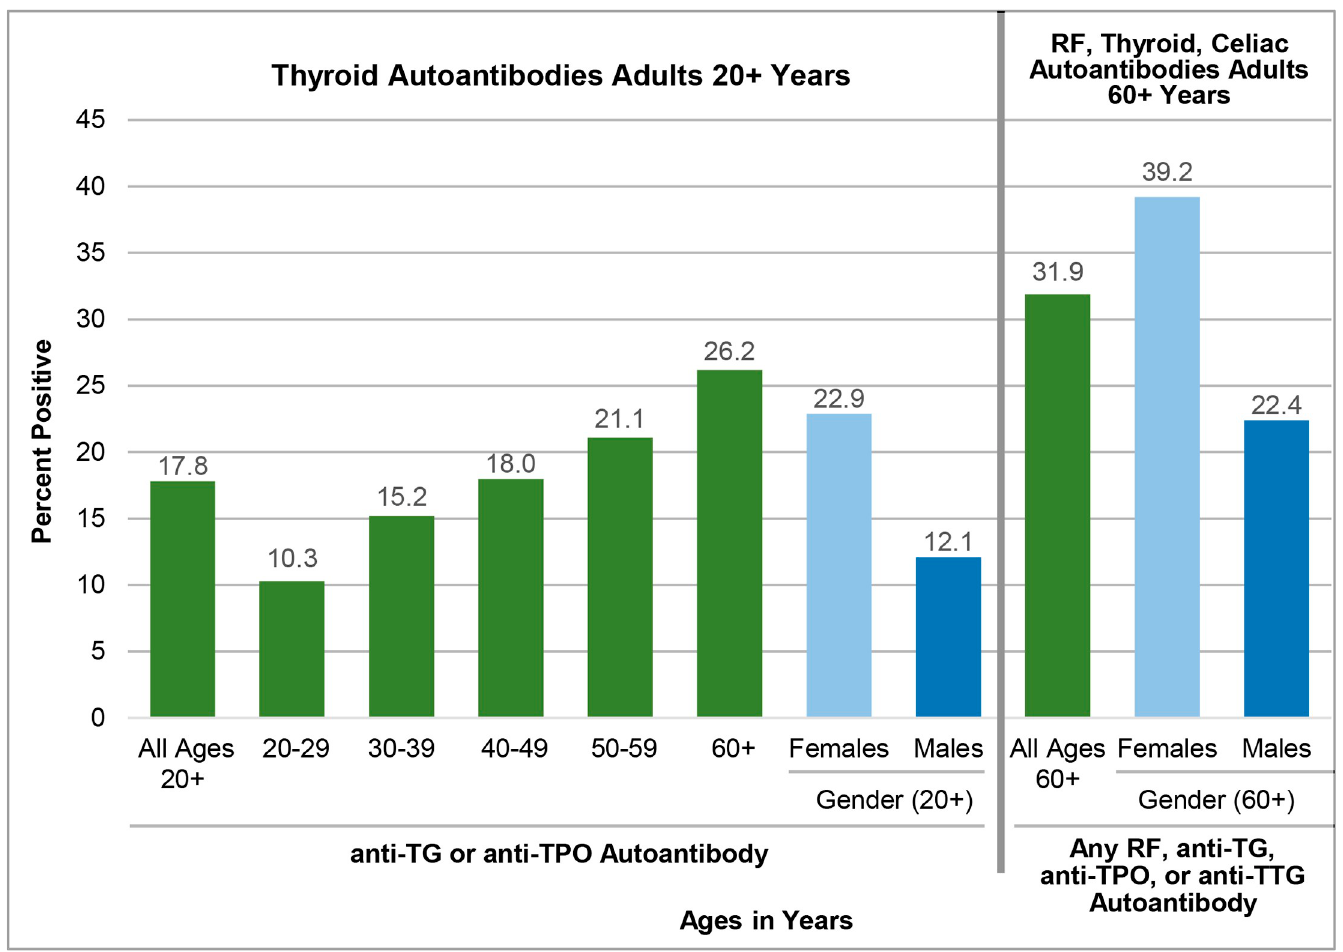
Fig 2. The prevalence of persons with a detectable serum autoantibody, NHANES 1988–1994. Abbreviations: RF = Rheumatoid Factor; TG = Thyroglobulin; TPO = Thyroid Peroxidase; TTG = Tissue Transglutaminase.